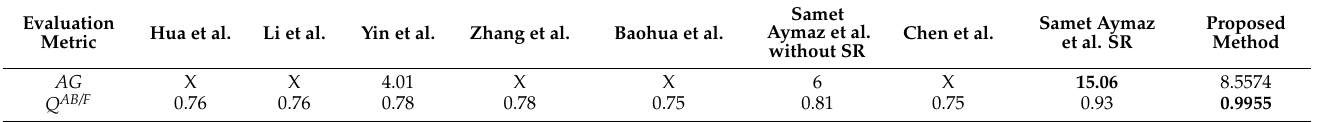
Table 33. The outcomes for the Pepsi image and comparisons with existing techniques in the literature ([24]).